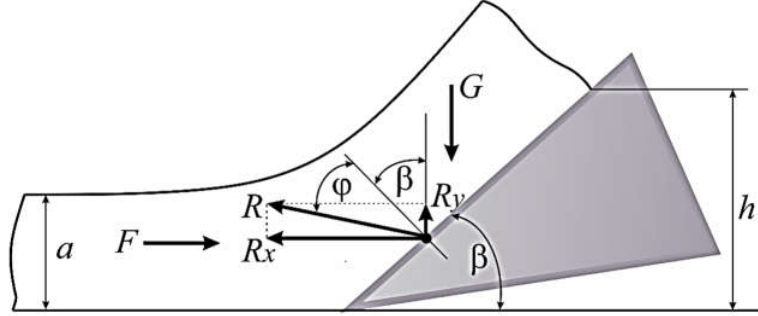
Figure 3. Skimmer power circuit during its interaction with the ground layer.